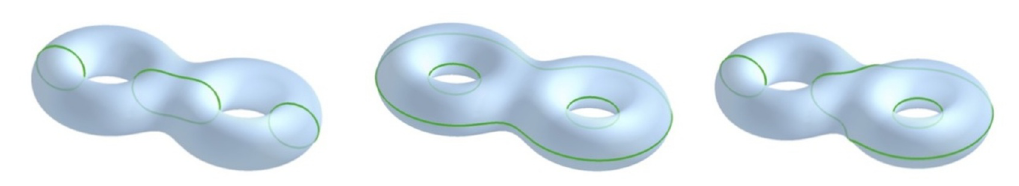
Figure 2 . Di(cid:11)erent Euclidean saddles with Z 2 time-re(cid:13)ection symmetry. They analytically con- tinue to three copies of thermal AdS 3 (left), three-sided wormhole (middle), and one thermal AdS 3 plus a BTZ black hole (right). The areas encircled by the green lines are the sets of (cid:12)xed points of the action of the Z 2